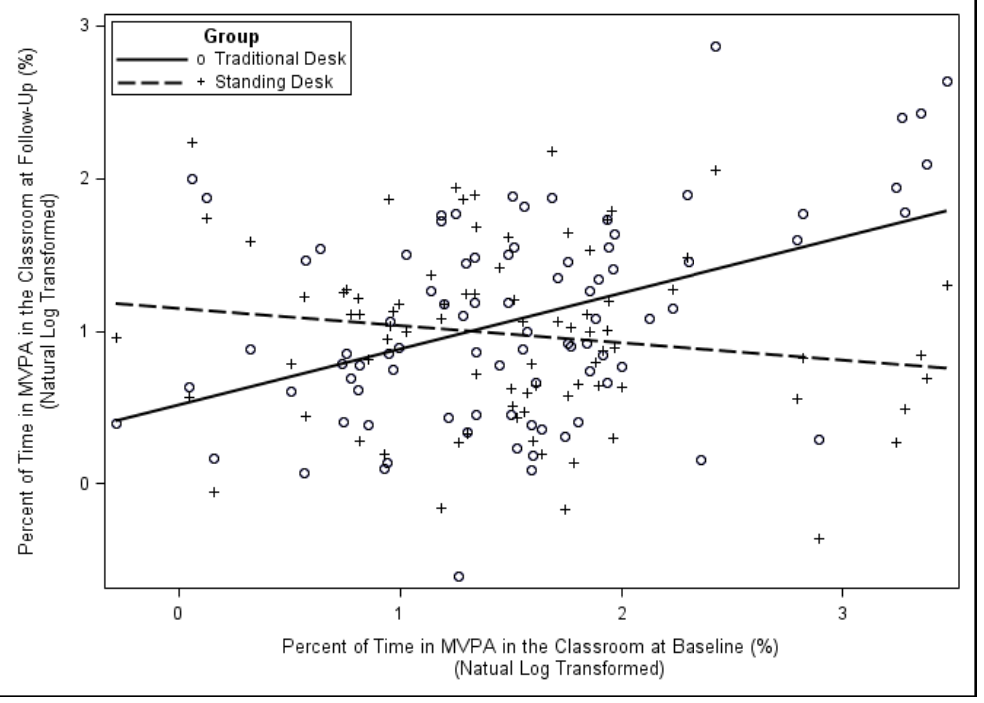
Figure 2. Relationship between MVPA at baseline and follow-up for students using traditional and stand-biased desks. (+ = Standing Desk; ○ = Traditional Desk). Note: As MVPA is not normally distributed, the figure is shown in their natural log transformed scale.